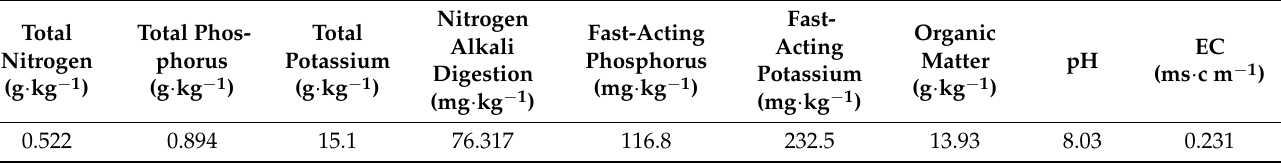
Table 1. Basic physical and chemical properties of soils.